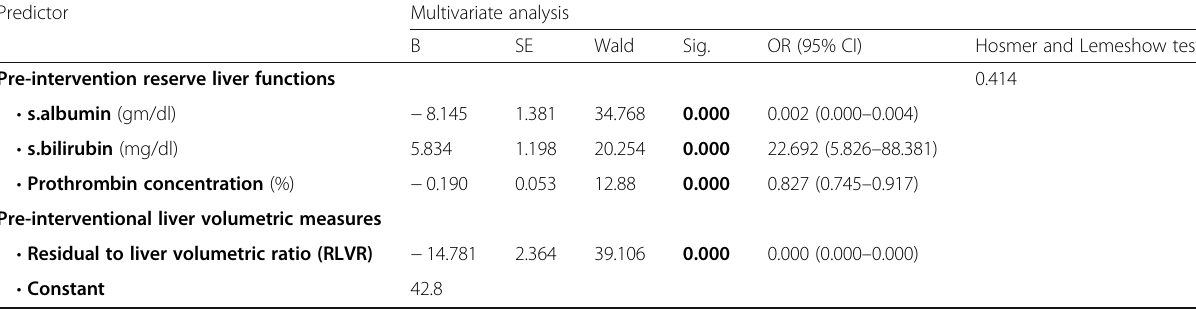
Table 3 Logistic regression analysis for the proposed predictors of liver decompensation Predictor Multivariate analysis B SE Wald Sig. Hosmer and Lemeshow